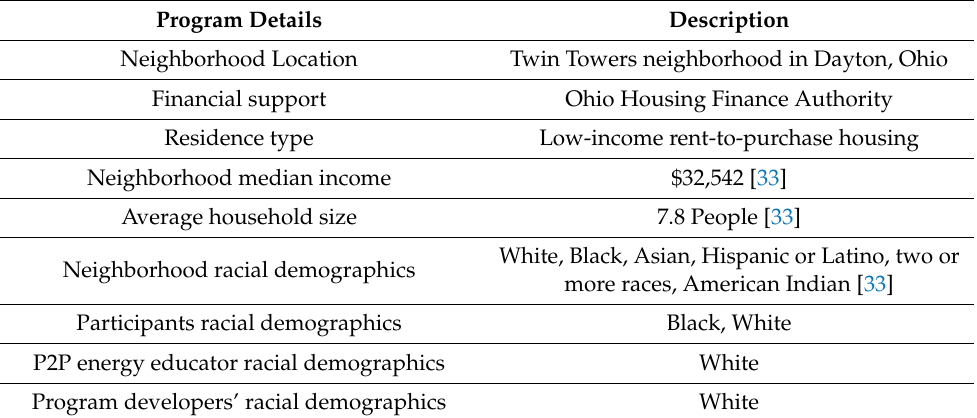
Table 1. Summary of Program